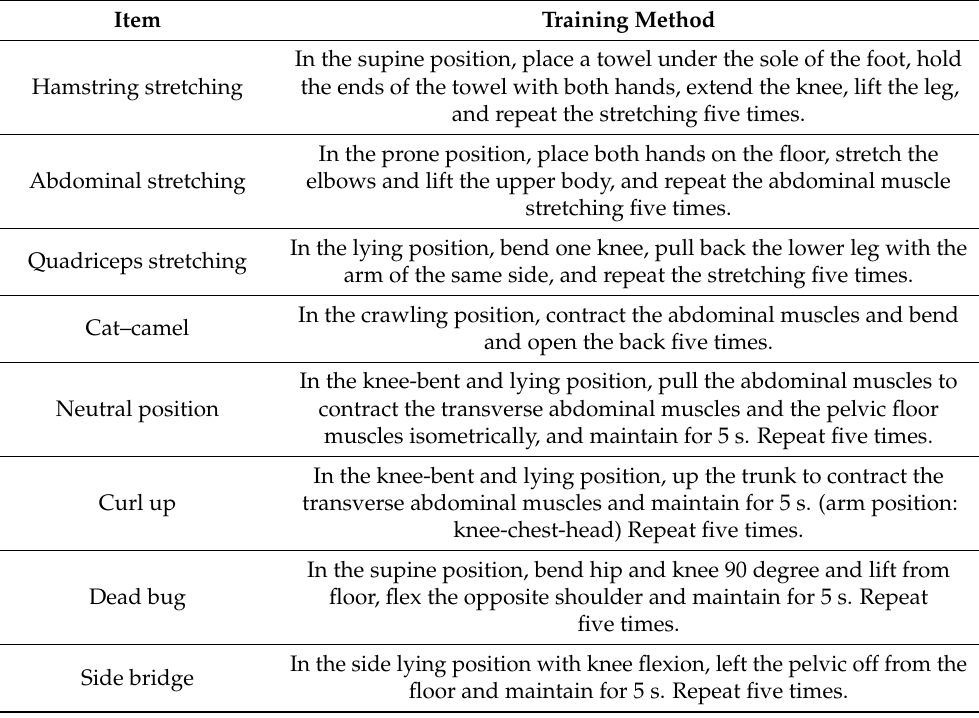
Table 2. Lumbar stabilization exercise on the